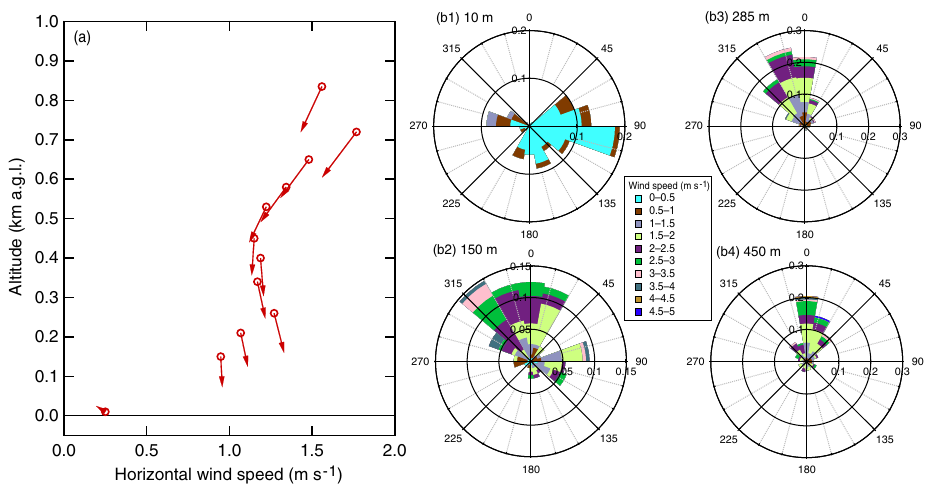
Figure 4. (a) Vertical profile of the average nighttime (19:00–07:00) horizontal winds over Visalia, CA (65km SE of Fresno), and the surface (10m) wind in Fresno for flight days during Episode 1 (18, 20, 21 and 22 January). The length of the arrows corresponds to the wind speed and the direction to the average wind direction, with the measurement height indicated by the circle on the tail of the arrow. (b) Corresponding wind roses for (b1) the surface, (b2) 125–175m, (b3) 225–345m and (b4) 400–500m. The length of each arc corresponds to the normalized probability and the colors indicate the wind speed (ms − 1 ; see legend). Data are from the National Oceanic and Atmospheric Administration, Earth System Research Laboratory, Physical Sciences Division Data and Image Archive (https://www.esrl. noaa.gov/psd/data/obs/datadisplay/, accessed 3 June